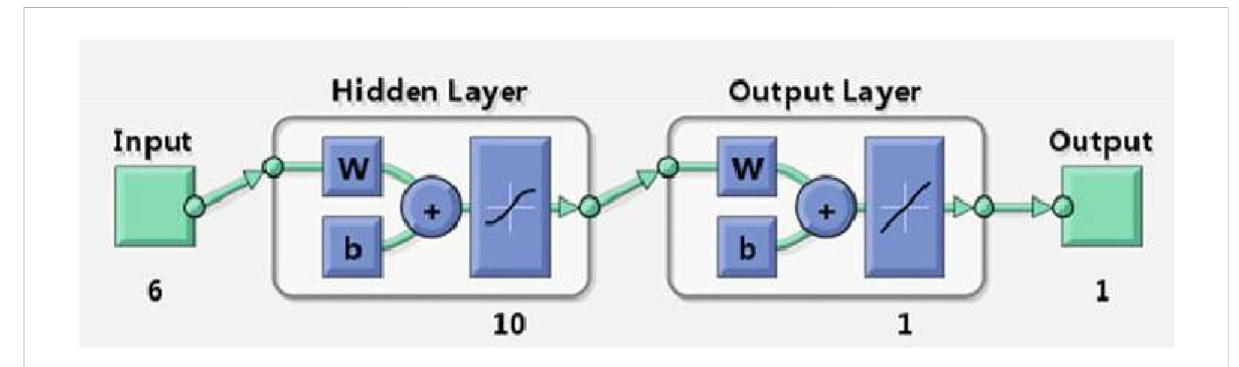
FIGURE 3 ANN network architecture 6-10-1 for R